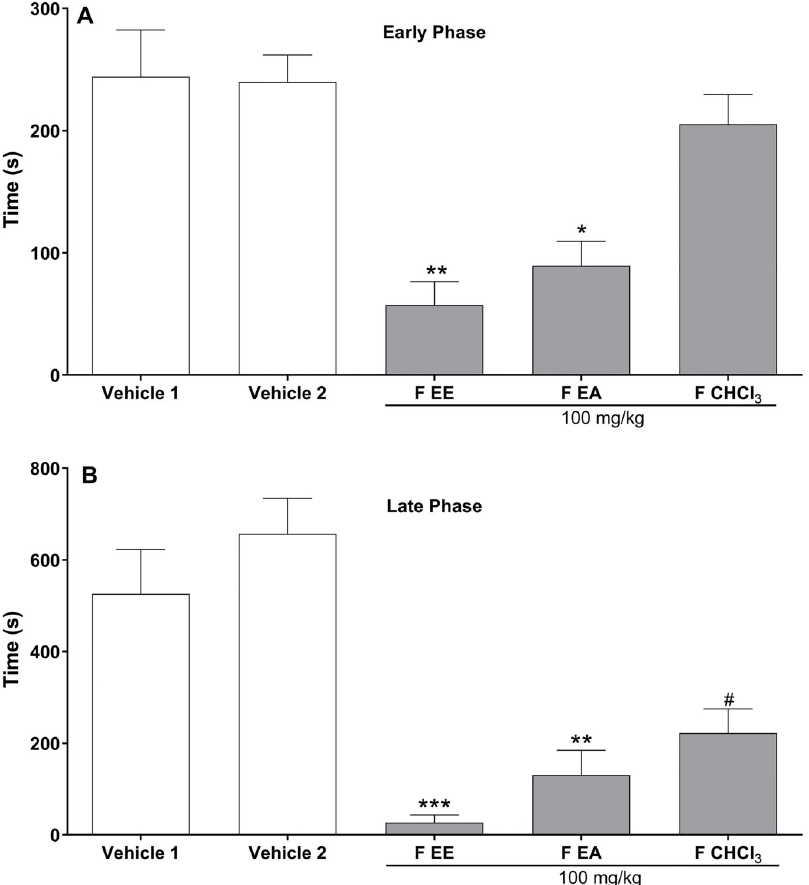
Fig 3. Effects of different fractions from methanol extract of D . vandellianum leaves (ME) on formalin test in mice. Mice were treated with vehicle (control groups) or fractions (100 mg/kg) by intraperitoneal route 40 min before the intraplantar injection of formalin (injected at time zero). FEE: ether fraction from ME (solubilized in saline); FEA: ethyl acetate fraction from ME (solubilized in 5% DMSO); FCHCl 3 : chloroform fraction from ME (solubilized in 5% DMSO). Vehicle 1: saline (control group of FEE). Vehicle 2: 5% DMSO plus saline (control group of FEA and FCHCl 3 ). Mice were observed from 0 to 10 min (early phase; A ) and from 10 to 30 min (late phase; B ), and a nociceptive score was determined for each period by counting the time in seconds that the animal spent licking the injected limb during the observation time. Data are expressed as mean times ± S.E.M.; n = 6 mice per group. � Significantly different from vehicle 1 group ( p < 0.05); �� significantly different from vehicle 1 group ( p < 0.01); ��� significantly different from vehicle 1 group ( p < 0.001); # significantly different from vehicle 2 group ( p < 0.01). ANOVA followed by Tukey’s test.